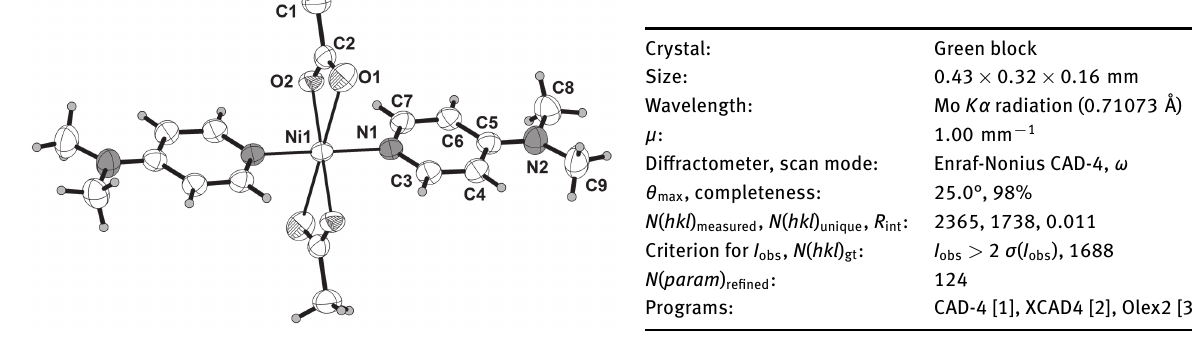
Table 2: Fractional atomic coordinates and isotropic or